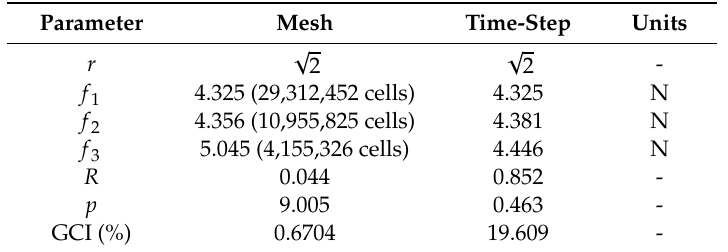
Table 4. Grid and time independence (rectangular canal, F h = 0.57). Experimental result: 4.5047 N. Parameter Mesh Time-Step Units √ √ r 2 2 - f 1 4.325 (29,312,452 cells) 4.325